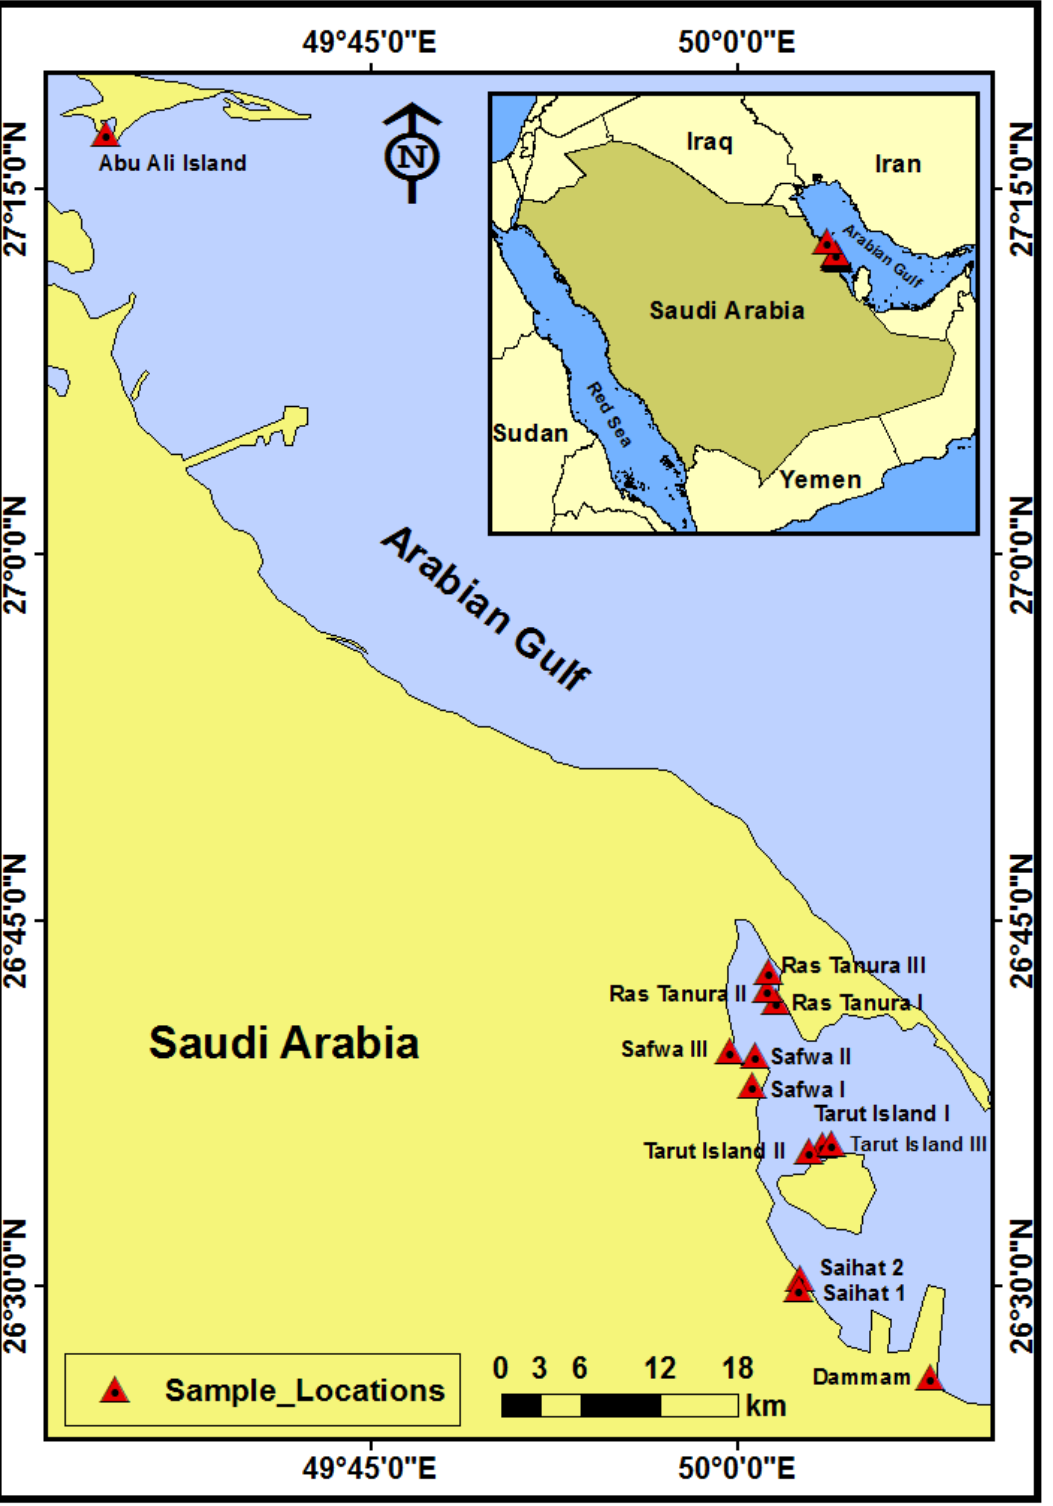
Figure 1: Sampling sites along the Saudi Arabian coast of the Arabian